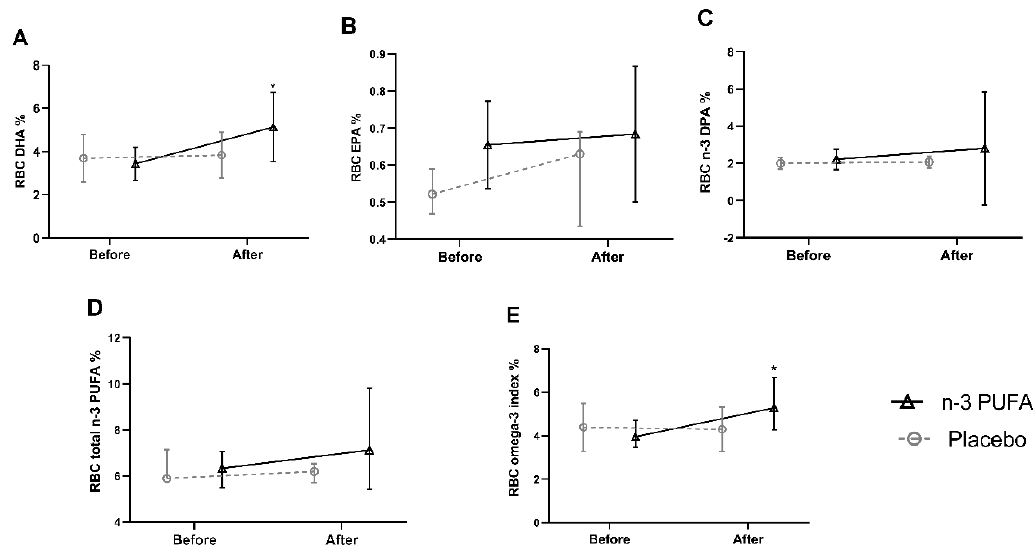
Figure 2. Percentage of DHA ( A ), EPA ( B ), n-3 DPA ( C ), total n-3 PUFAs ( D ), and omega-3